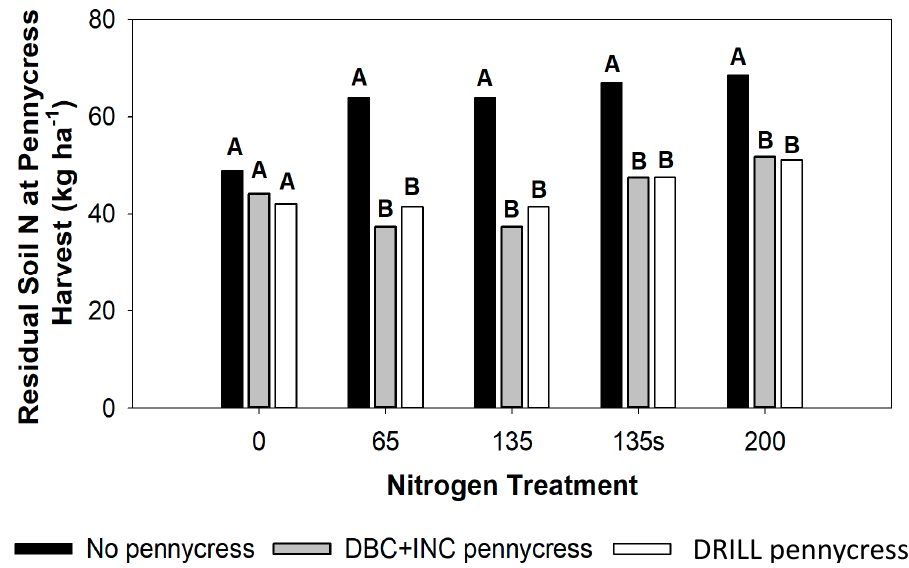
Figure 2. Interactive effect of sweet corn N fertilizer rate (N Treatment) and cover crop treatment on mean residual inorganic soil N at pennycress harvest for the Rosemount in 2017. Values within N treatment followed by different letters are significant ( p ≤ 0.05). Data was log transformed for analysis and back transformed for presentation.